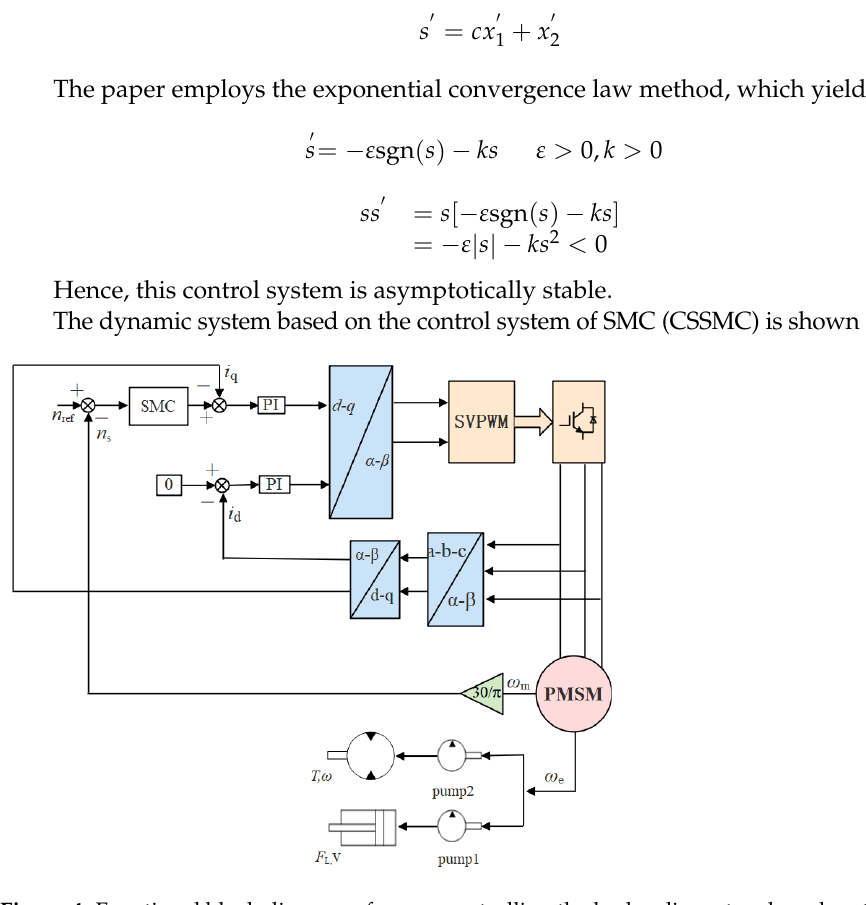
Figure 4. Functional block diagram of pump controlling the hydraulic system based on the CSSMC.